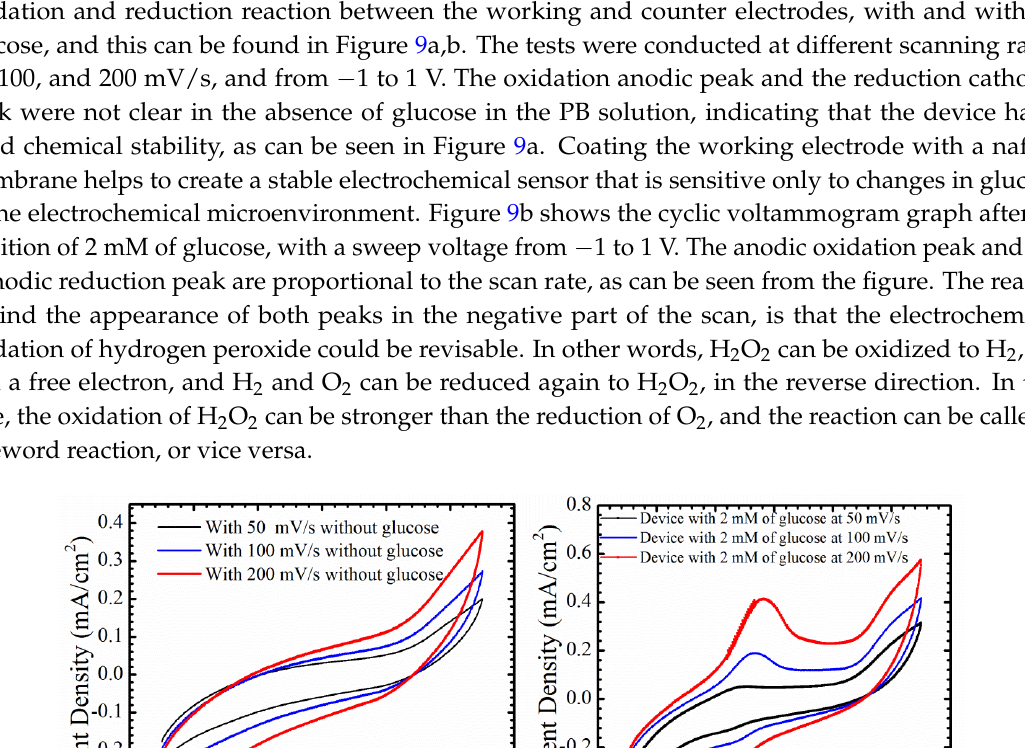
Figure 9. Cyclic voltammetry of the fabricated Si/SiO 2 /Au/ZnO NRs/GO x /Nafion with and without glucose at different scanning rates, 50, 100, 200 mV/s. ( a ) Absence of glucose; ( b ) Presence of